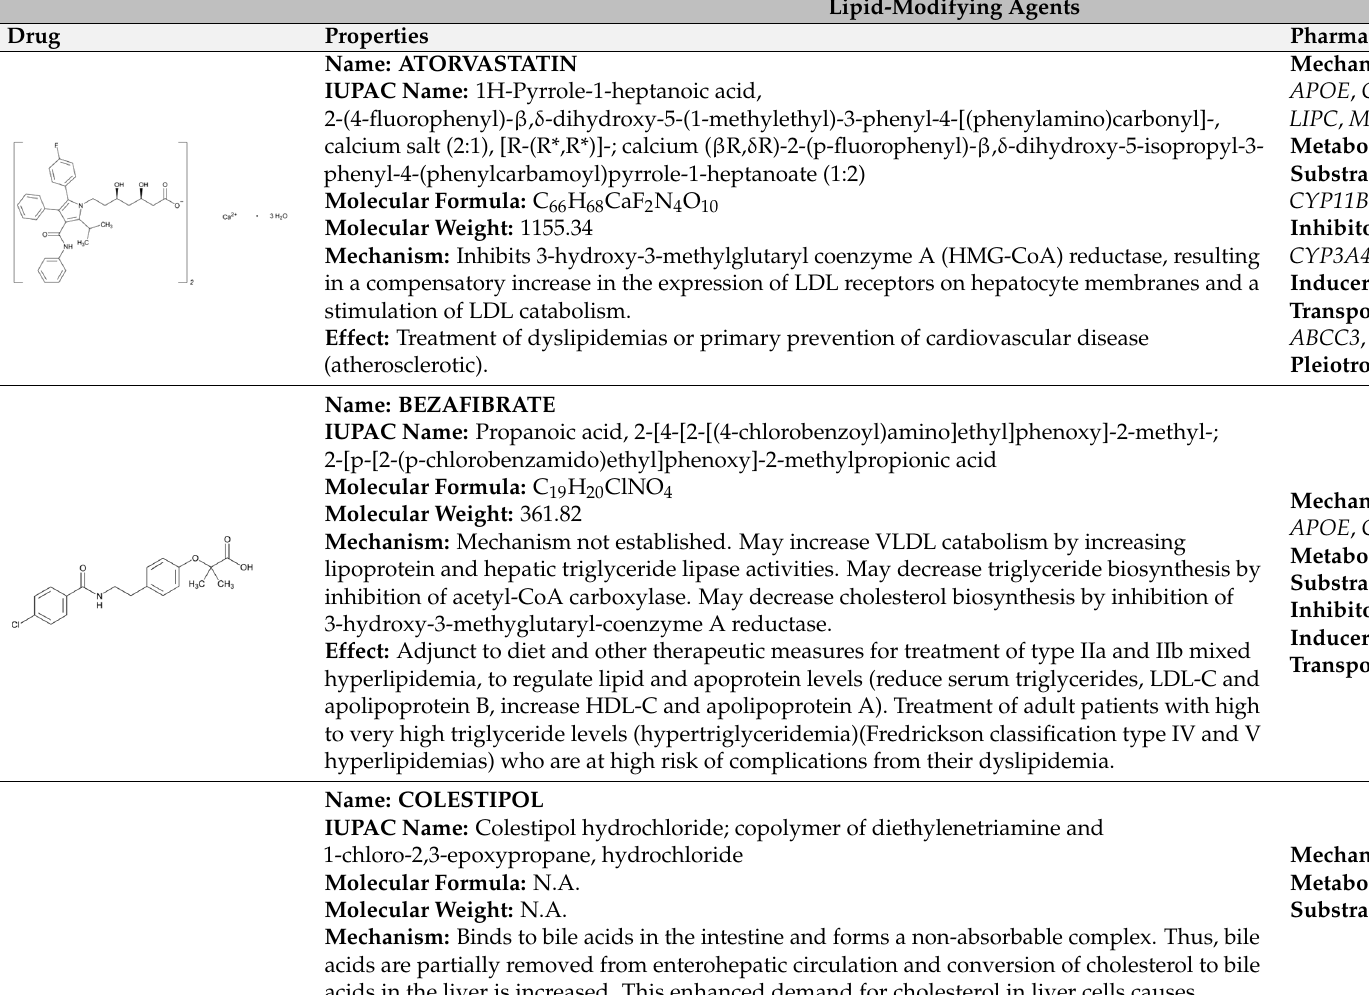
Table 2. Pharmacogenetics of lipid-modifying agents. Lipid-Modifying Agents